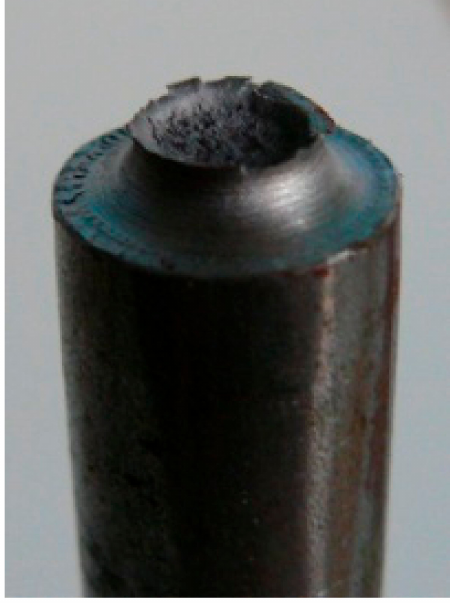
Figure 11. Macroscopic photograph of a fracture surface of a tensile notched specimen. Transi- tion from the flat failure mechanism in the specimen center to the slant fracture at the edges is clearly visible. The first mechanism involves normal stress, while in the latter, shear stress plays a dominant role.